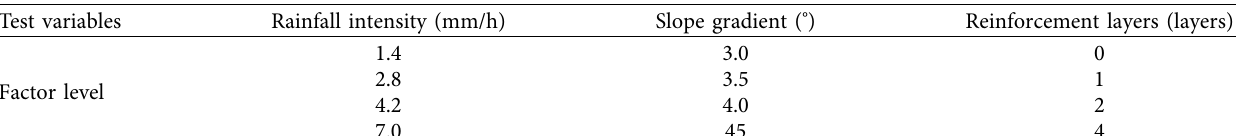
Figure 4: Establishment process of experimental soil sample: (a) soil sample; (b) fill embankment construction; (c) fill embankment construction; (d) final model. Table 3: Test scheme.